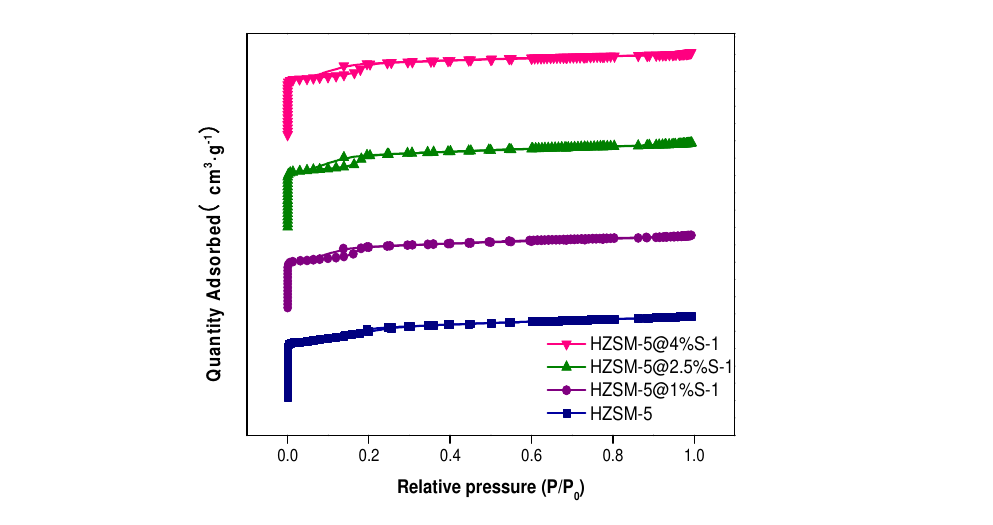
Figure 3. N 2 adsorption/desorption isotherms of the as prepared parent HZSM-5 and HZSM-5@silicalite-1 samples. Table 1. Textural properties of the as prepared parent HZSM-5 and HZSM-5@silicalite-1 catalysts.